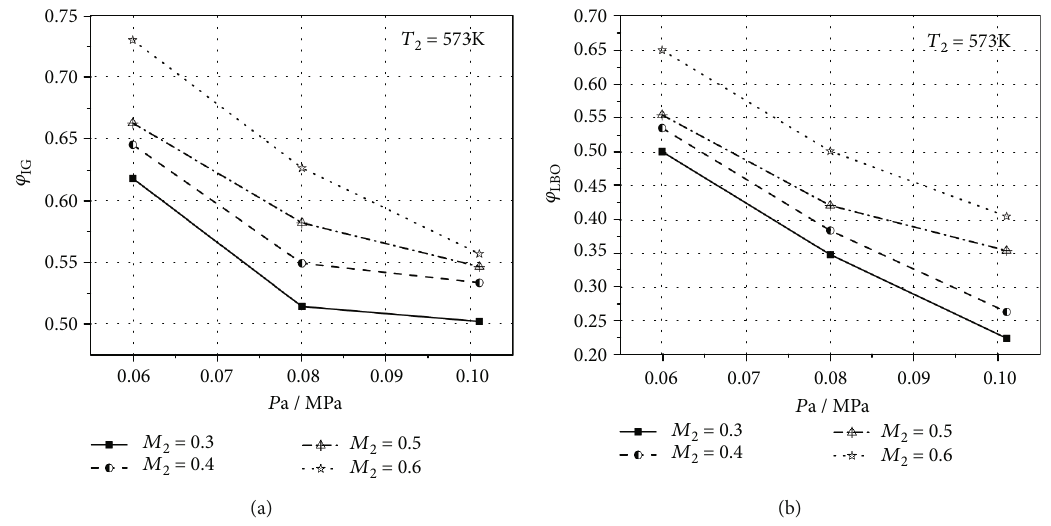
= 573 K : (a) lean ignition, (b) 2